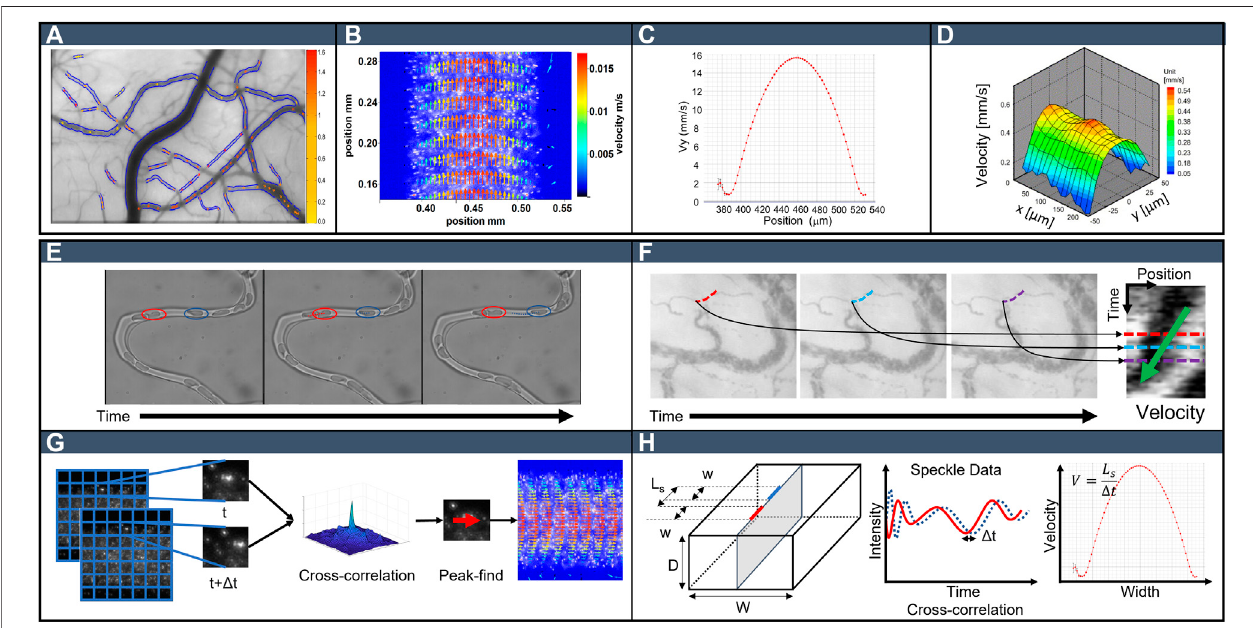
FIGURE1|(A-D) :Visualcomparisonoftypicalvelocity fi elds. (A) Colormapoflocalvelocityinaconjunctivalmicrocirculationnetwork.Colorbarrepresentsvelocity in units of mm/s. The velocity vectors were obtained using kymographs image reused per United States government copyright (Khansari et al., 2015). (B) Field of 2D velocity vectors pro fi le across a glass round 150 mm diameter capillary channel where blood, at 10% hematocrit, was fl owing at a fl ow rate of 11.5 ml/min. The velocity vectors were obtained in our lab using micro-PIV. (C) Space-time averaged velocity corresponding to the fi eld of 2D velocity vectors presenting in (B) . (D) Instantaneous 3D velocity pro fi le of blood sample at 17% hematocrit in the central plane of a rectangular microchannel in in vitro analysis. Data were obtained using confocal micro-PIV, image reused with permission, copyright, 2022, Elsevier (Lima et al., 2007). (E-H) : Methods ’ schematic of velocity determination (E) Cell tracking. The image presents in vitro RBCs in semi-circular curved channel (F) Kymograph. The image presents in vivo Sublingual microcirculation. (G) Micro-PIV. Images show fl uorescent particles in the blood. (H) Dual slit